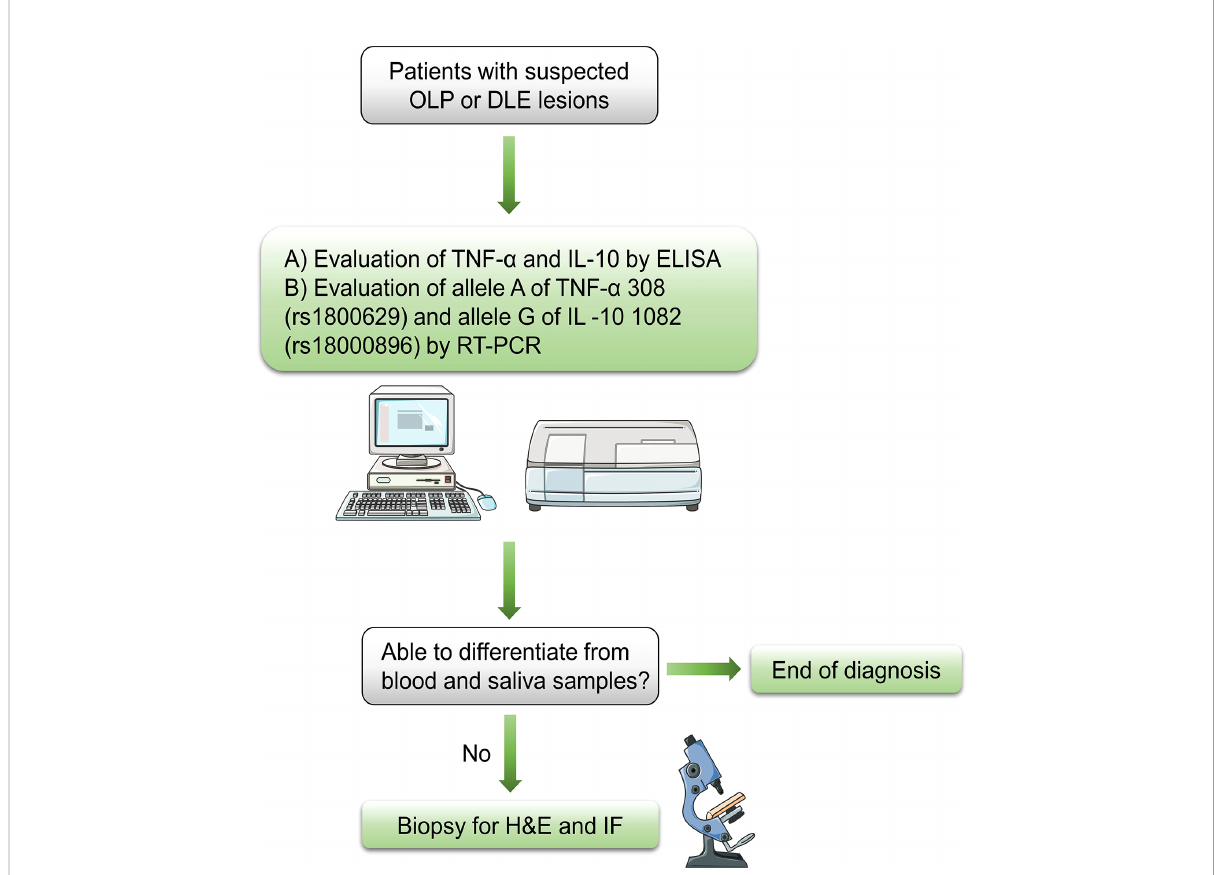
FIGURE 2 Flow chart for diagnosis of suspected OLP or DLE lesions OLP, oral lichen planus; DLE, discoid lupus erythematosus; ELISA, enzyme linked immunosorbent assay; RT-PCR, reverse transcriptase polymerase chain reaction; H&E, hematoxylin and eosin; IF, immuno fl